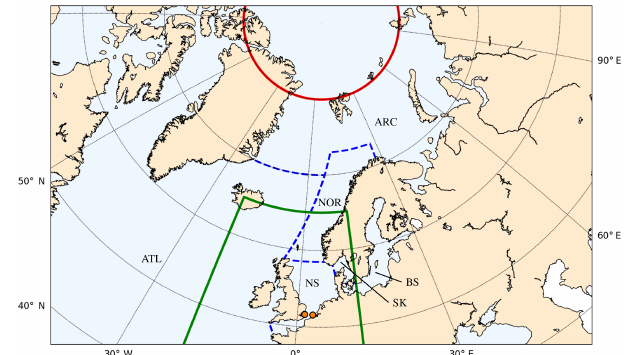
Figure 5. Spatial coverage of the OGCM data used to study North Sea microplastic transport. NEMO data are available globally. NWS data are available for the North Sea region (green boundary) and WaveWatch III data are available south of 80 ◦ N (red boundary). The particle releasing locations are the Rhine and Thames estu- aries (orange dots) and the region is split into six zones: North Sea (NS), Skagerrak and Kattegat (SK), Baltic Sea (BS), Norwe- gian Coast (NOR), Arctic Ocean (ARC), and Atlantic Ocean (ATL), which are separated by the dashed blue